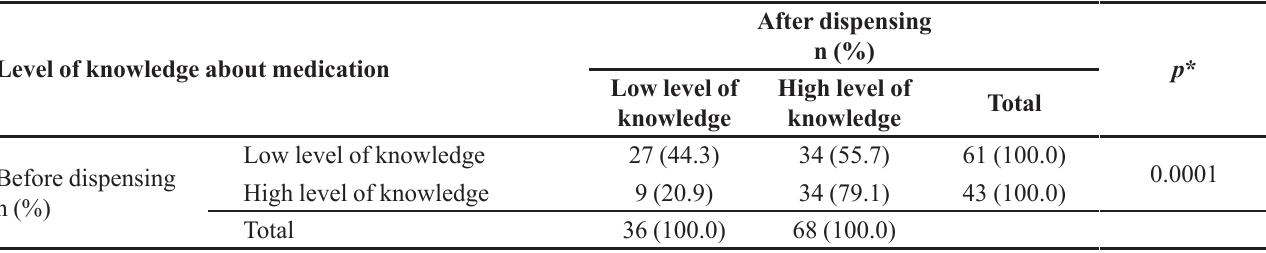
TABLE III - Patient knowledge about medications before and after the dispensing process at the Campus Pharmacy, Goias, Brazil,